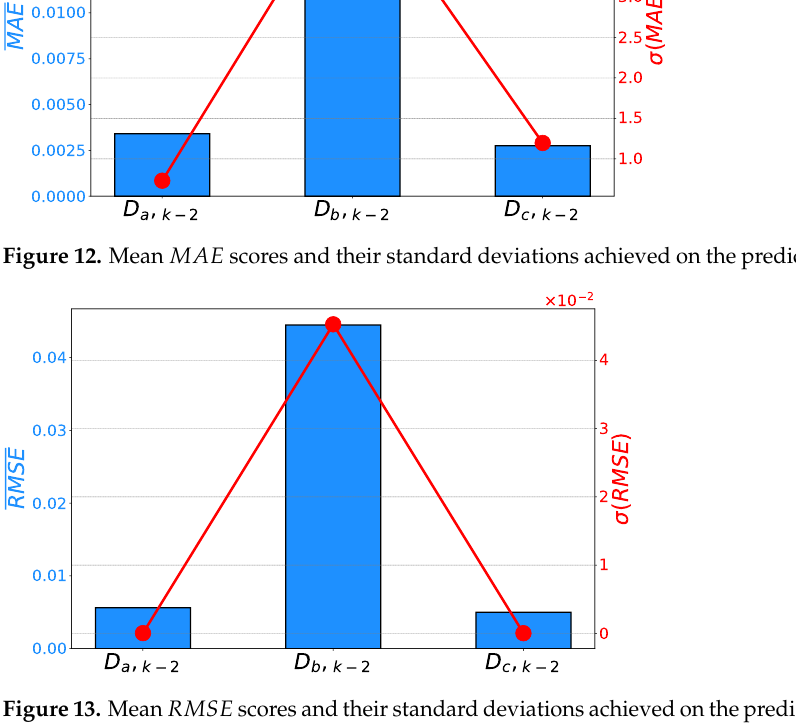
Figure 13. Mean RMSE scores and their standard deviations achieved on the prediction of duty